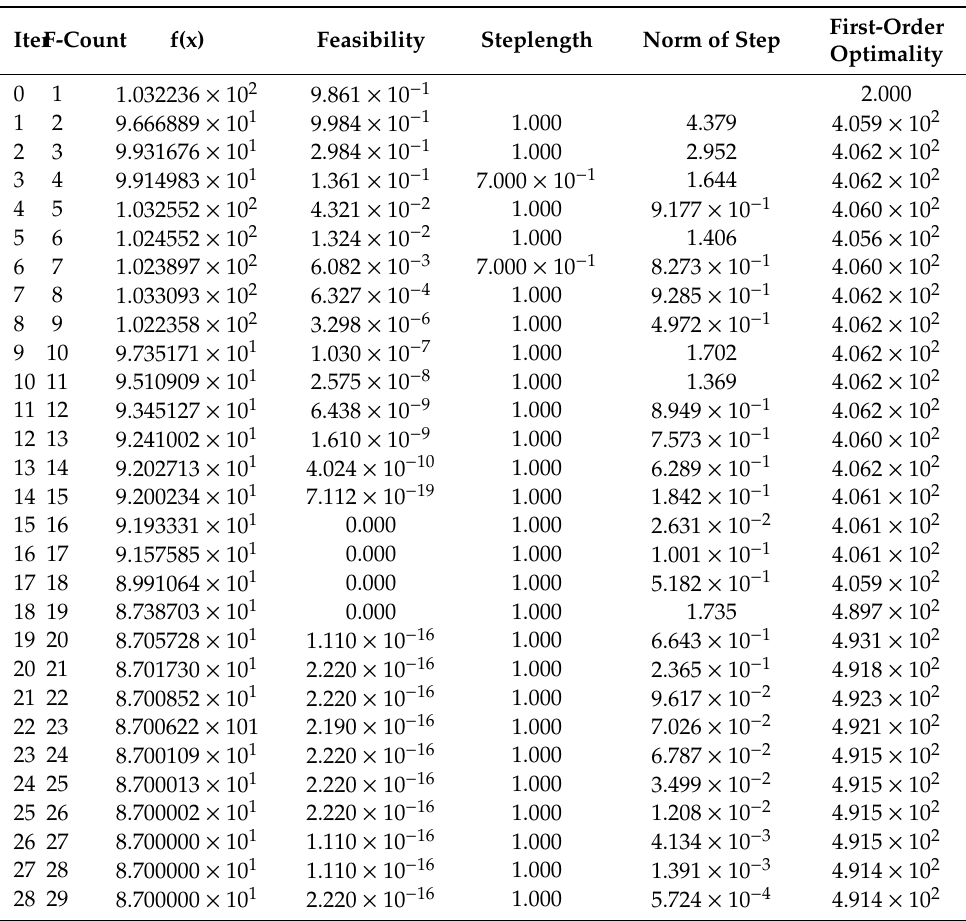
Table A3. Simulation results on underdetermined system of